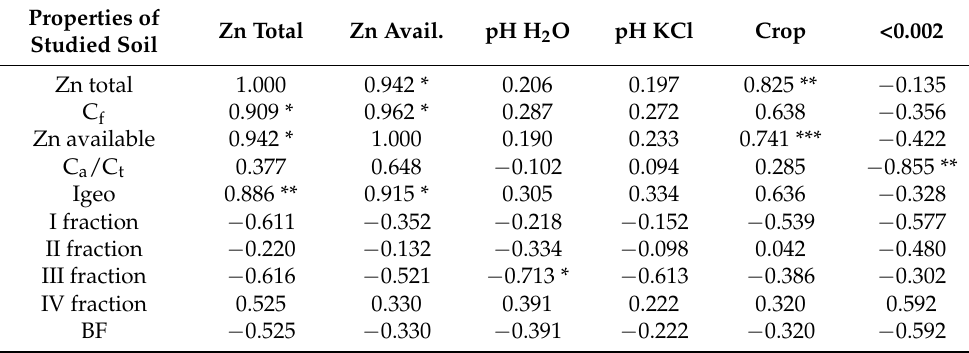
Table 3. Values of Pearson’s correlation coefficients of zinc forms and indices with the physicochemi- cal properties of silty